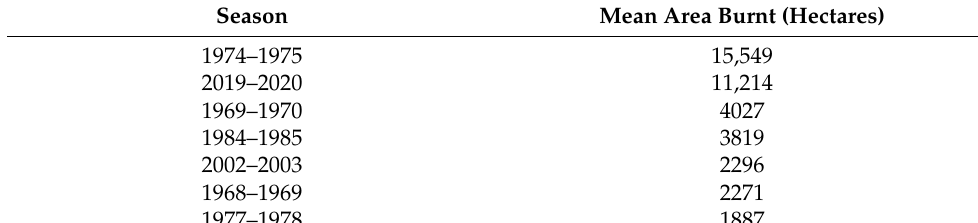
Table 1. Statistical outliers.